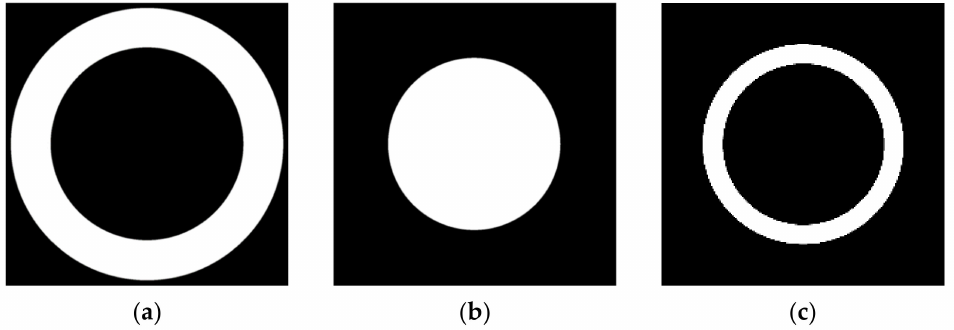
Figure 3. The binarized CT images. ( a – c ): rock phase, cement phase, interface between cement and